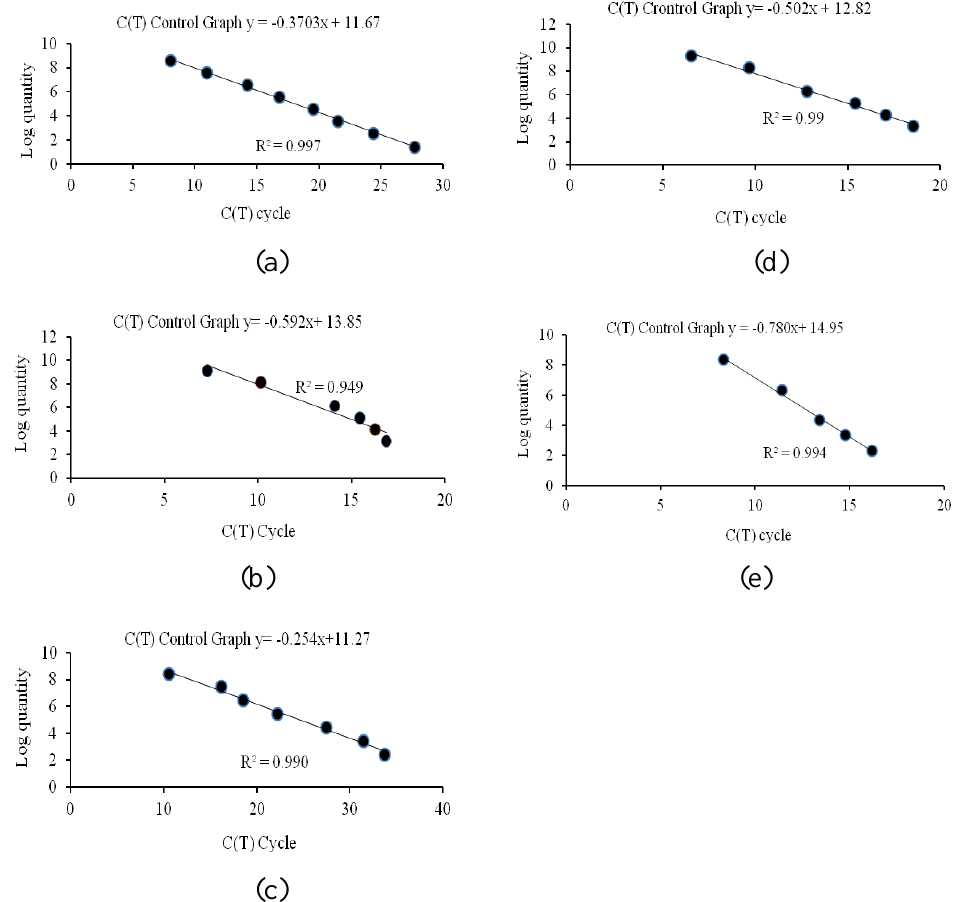
Figure 1. The standard curves obtained by plotting the logarithm of DNA concentration for total bacteria (a), methanogen (b), F. succinogenes (c), R. flavefaciens (d) and R. albus (e) versus threshold cycle (Ct) for population quantification by using real time